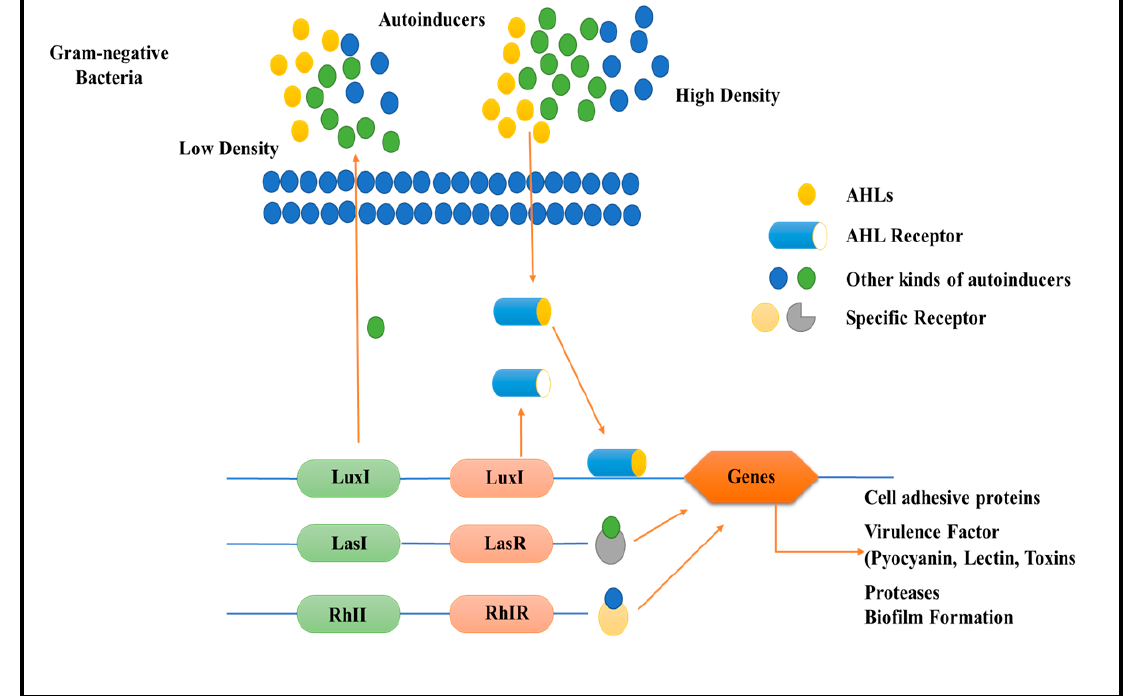
Figure 3. Diagram describes quorum sensing signalling mechanism in Gram-negative bacteria relation and biofilm development role. Gram-negative bacteria frequently created (AHLs) during communication, which activated the relevant cytoplasmic receptors to modify the expression of the targeted genes. Luxl/luxR transcriptional factors of QS in Gram-negative bacteria.